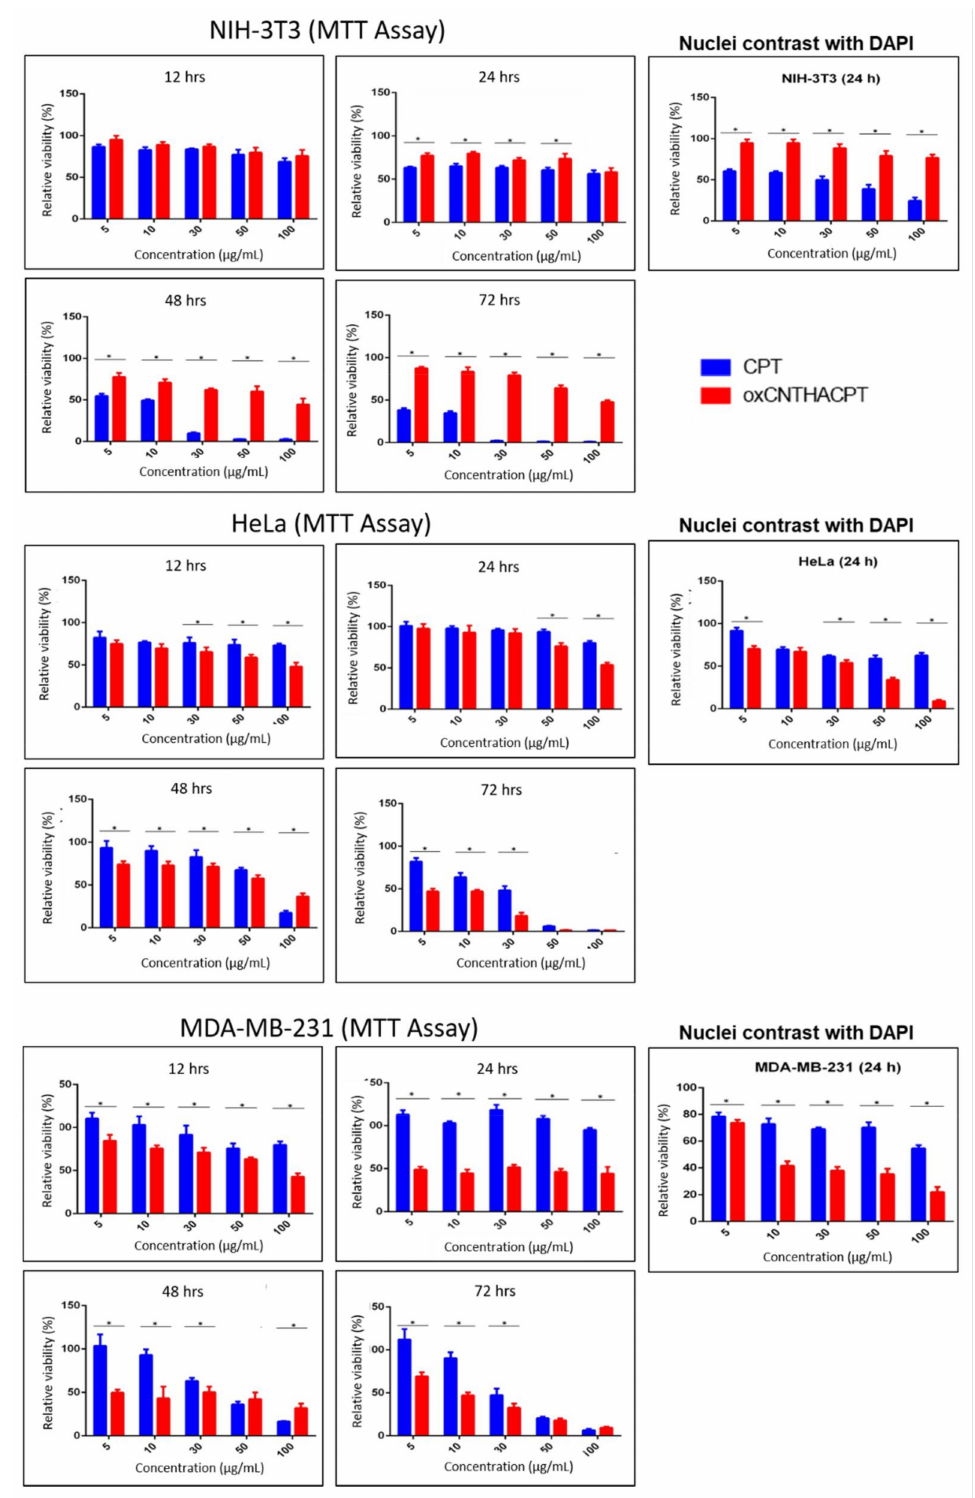
Figure 5. Graphs of the MTT and DAPI assays that represent the viability of the NIH-3T3, HeLa, and MDA-MB-231 cell lines after administration of CPT (blue bar) and oxCNT-HA-CPT (red bar) at doses of 0, 5, 10, 30, 50, and 100 µ g/mL and 12, 24, 48 and 72 h of exposure. Note that, after 24 h of exposure, CPT has a greater cytotoxic effect on non-tumor cells, compared to oxCNT-HA-CPT. On the contrary, the oxCNT–HA–CPT nanovector has a greater cytotoxic effect on tumor cells compared to CPT. (n = 5). Statistical test of Student’s T. P < 0.05. The * indicates statistical